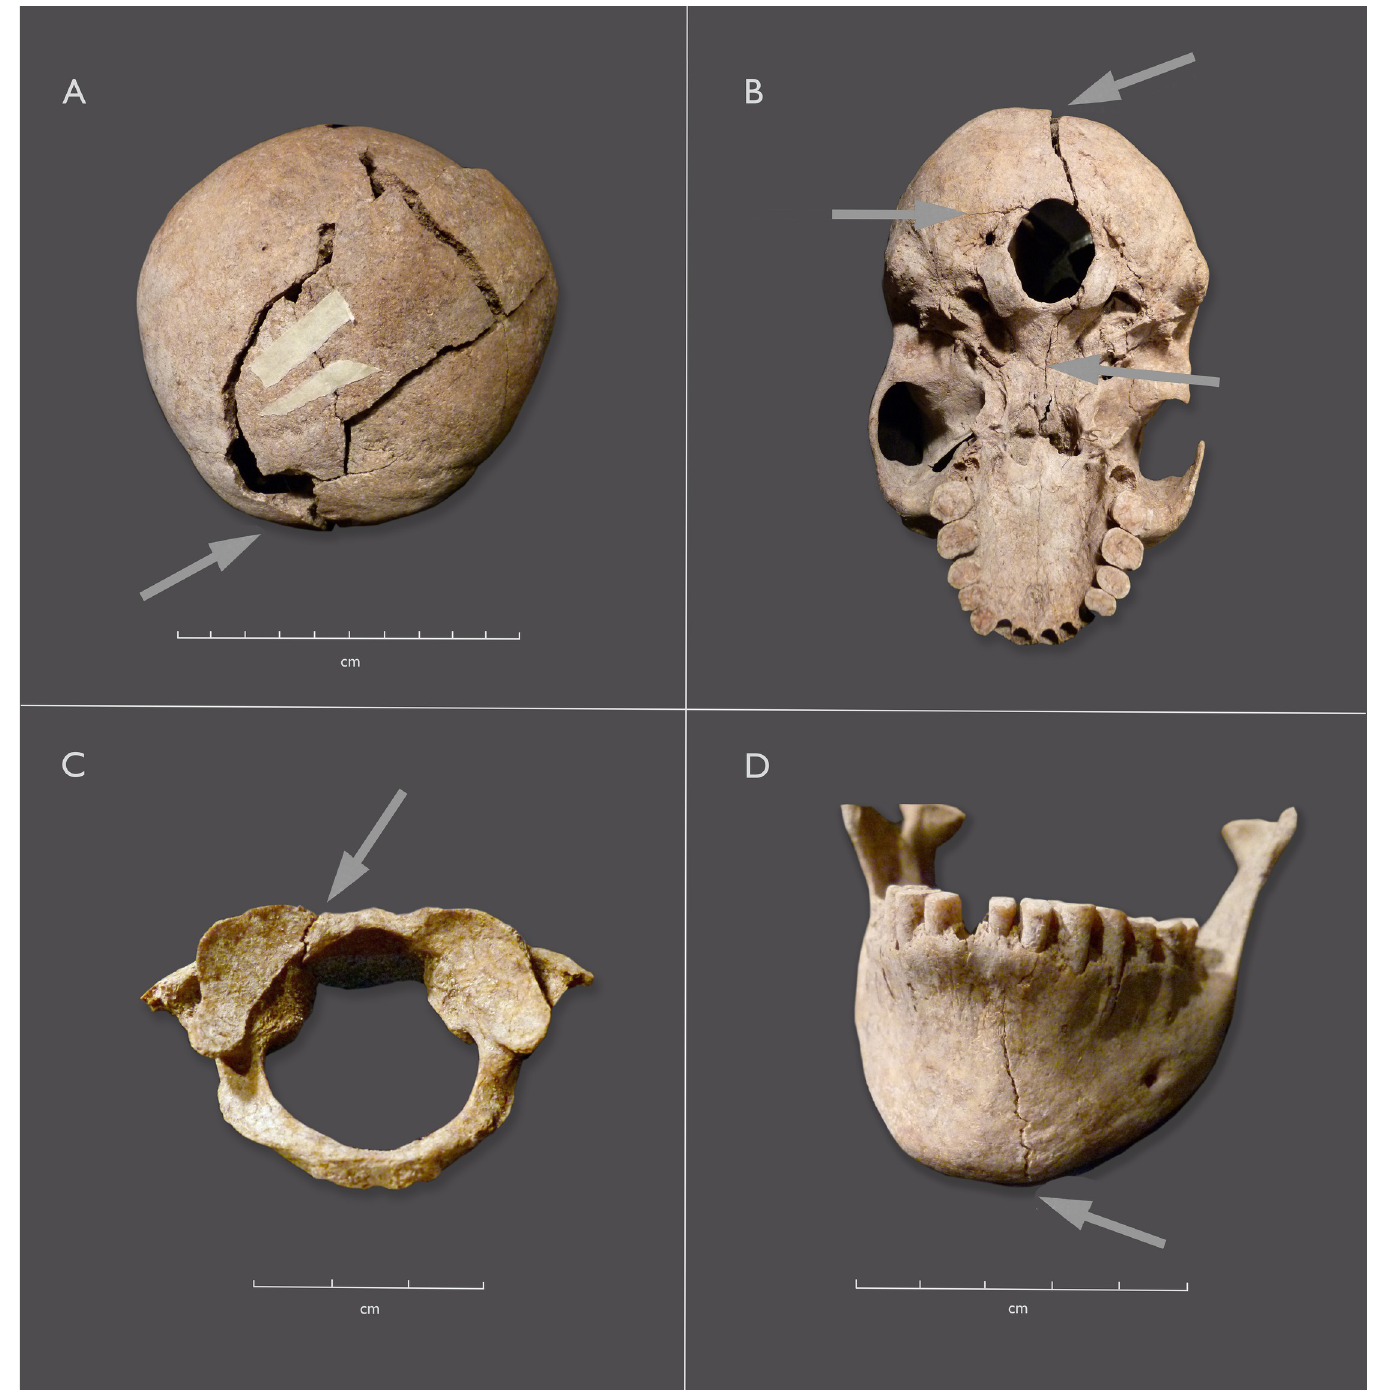
Fig 5. Individual 1, SAM-AP 6421, cranial trauma. A. Posterior view of skull, with locus of force indicated by white arrow. B. Inferior view, showing continuation of radiating crack through the cranial base. C. First cervical vertebra (atlas), crack indicated by arrow. D. Mandible, vertical crack through only the anterior body. Individual 2 (SAM-AP 6423/25): This skeleton is of a particularly small adult, with cranial and pelvic morphology fully consistent with female sex. There are extensive ‘parturition scars,’